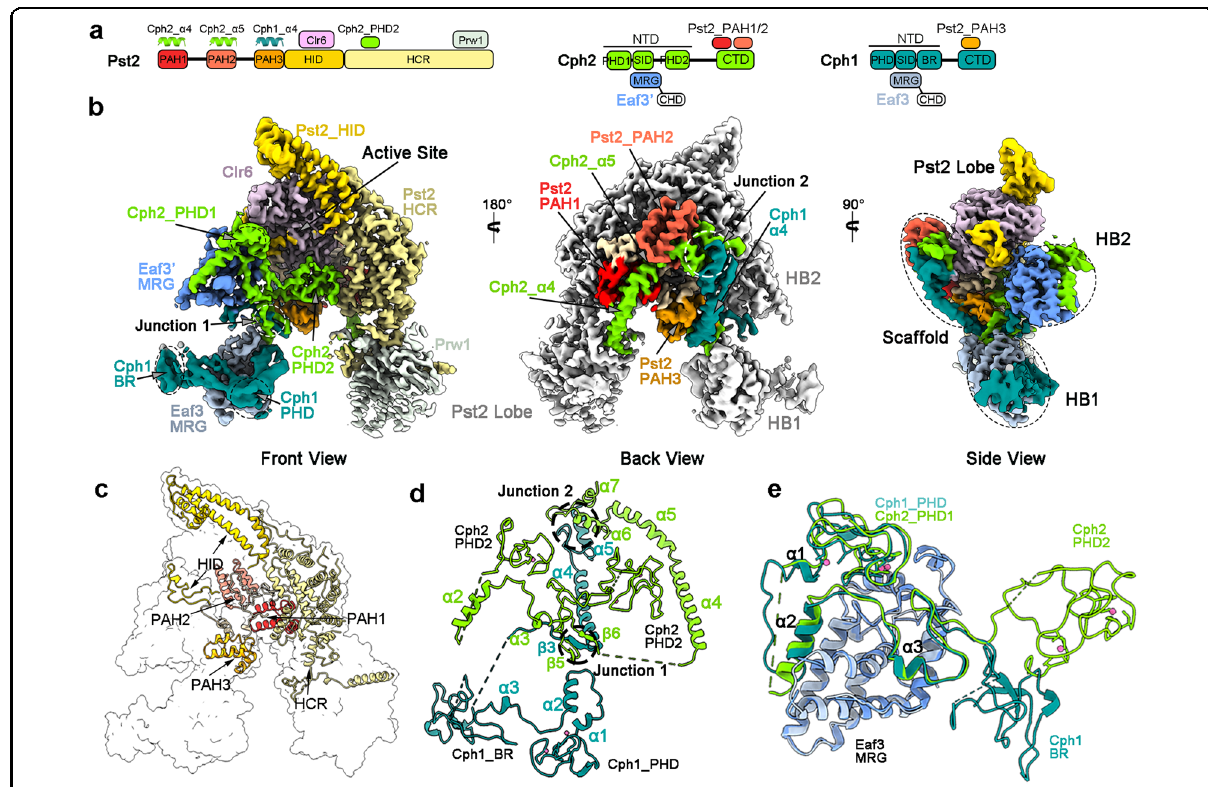
Fig. 3 Organization of the SIN3S complex. a The domain organizations of Pst2, Cph2, and Cph1. b The EM map of the SIN3S complex is shown in three different views. The SIN3S complex contains four modules: Pst2 Lobe (Pst2_HID/HCR, Clr6, and Prw1), two histone binding modules (HB1, consisting of Cph1_NTD and Eaf3; and HB2, consisting of Cph2_NTD and Eaf3 ’ ), and scaffold (Pst2_PAH1-3, Cph1_CTD, and Cph2_CTD). c The structure of Pst2 (shown in a cartoon model) in the SIN3S complex (shown in the surface model). d The structure of Cph1 and Cph2. The CTDs of Cph1 and Cph2 form the scaffold with the PAH1/2/3 of Pst2. The NTDs of Cph1 and Cph2 recruit the MRG domains of Eaf3 and Eaf3 ’ through their SID domains ( α 2 – 3), forming the HB1 and HB2 modules, respectively. e The structures of HB1 and HB2 are superposed by the MRG domains. Cph1_PHD is aligned well with the Cph2_PHD1, while the Cph2_PHD2 is away from the BR domain of